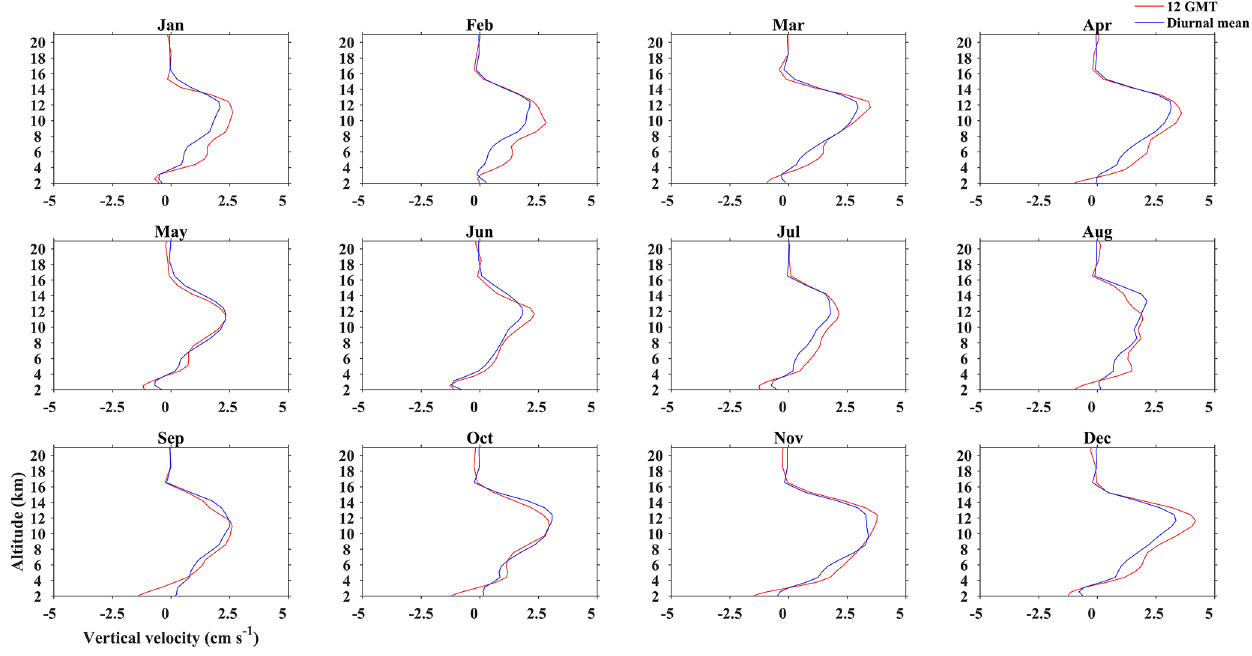
Figure 9. Same as Fig. 8 but for Kototabang during